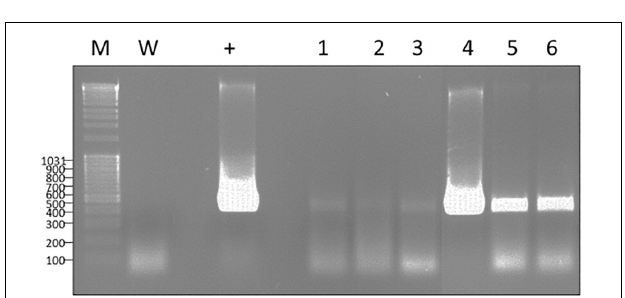
FIGURE 4 | RT-PCR exhibiting the capacity of TMV to infect and to move systemically into N. alata plant in 14 days. Use of specific primers to movement protein gene (502 bp); M, Marker; W, water; +, RNA from N. benthamiana infected by TMV; 1, 2, 3, RNA of different parts of N. alata plant inoculated with safety N. benthamiana extract; 4–6, RNA of different parts of N. alata plant inoculated with N. benthamiana extract infected by TMV; 1 and 4, RNA from inoculated leaf; 2 and 5, RNA from pitcher attached to inoculated leaf; 3 and 6, RNA from neighboring leaf. Parts of gels separated by a space were grouped together and lined up to facilitate the visualization of results. Any changes touching the quality of picture were applied to every pixel of each